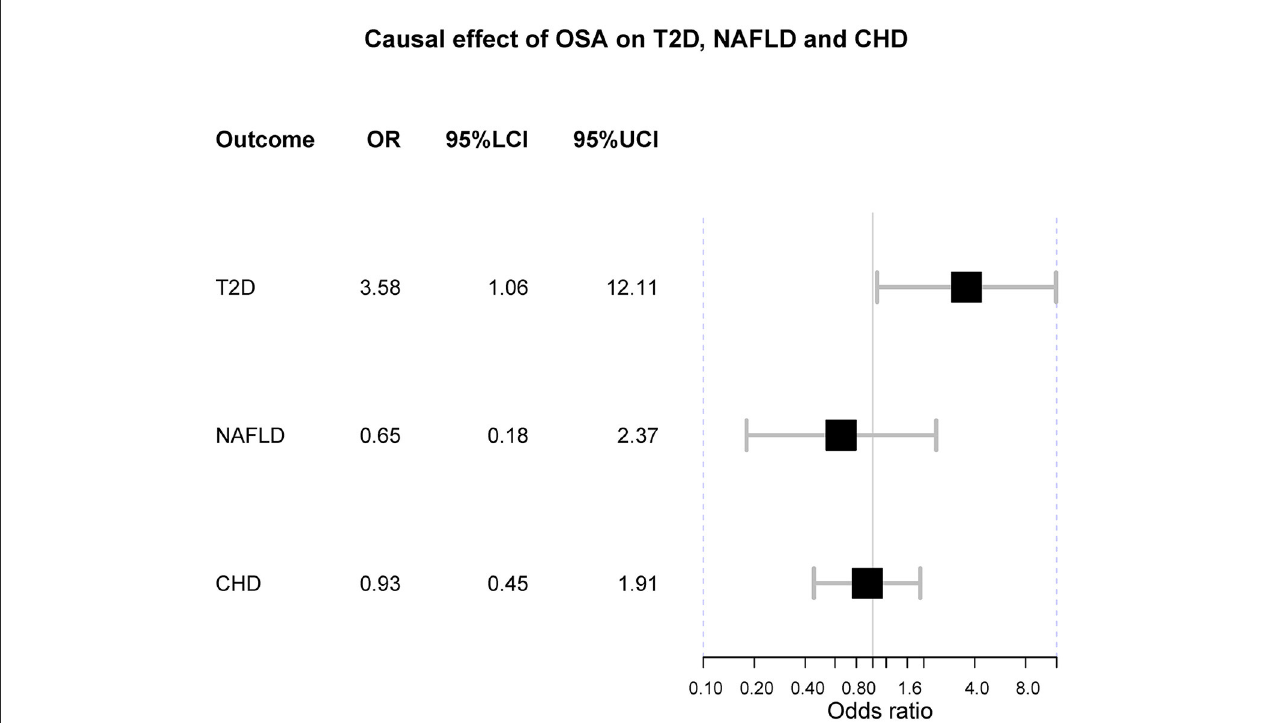
FIGURE2 The forest plot of Mendelian randomization. OSA is obstructive sleep apnea; T2D is type 2 diabetes; NAFLD is nonalcoholic fatty liver disease; CHD is coronary heart disease; OR is odds ratio; 95%LCI is the lower limit of 95% confidence interval of OR; 95%UCI is the upper limit of 95% confidence interval of